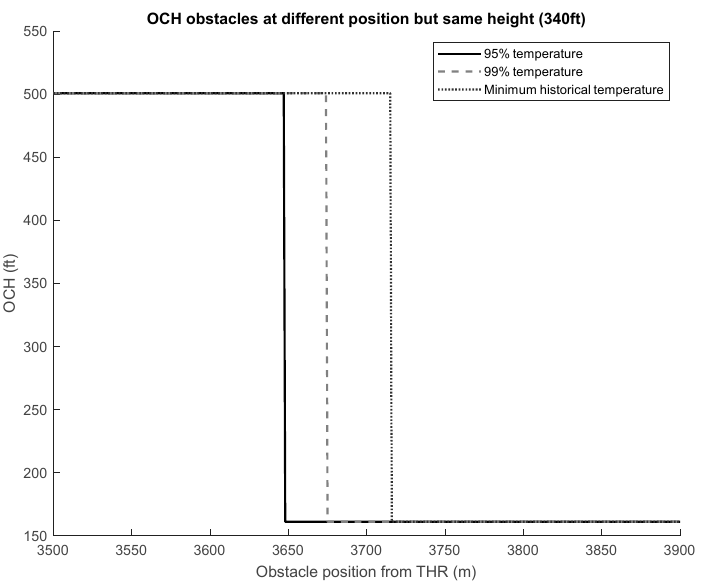
Figure 14. OCH for the same obstacle sited at di ff erent sites.